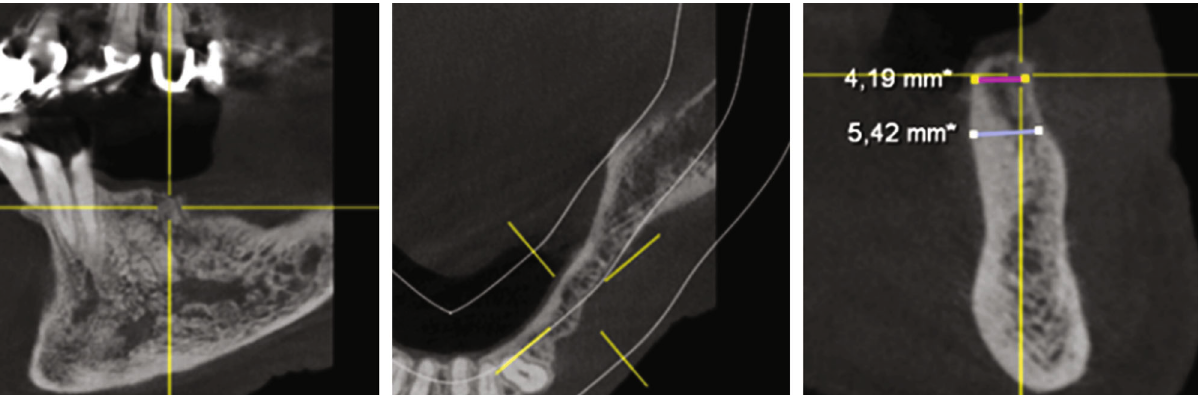
Figure 5: DVT — section region 35.